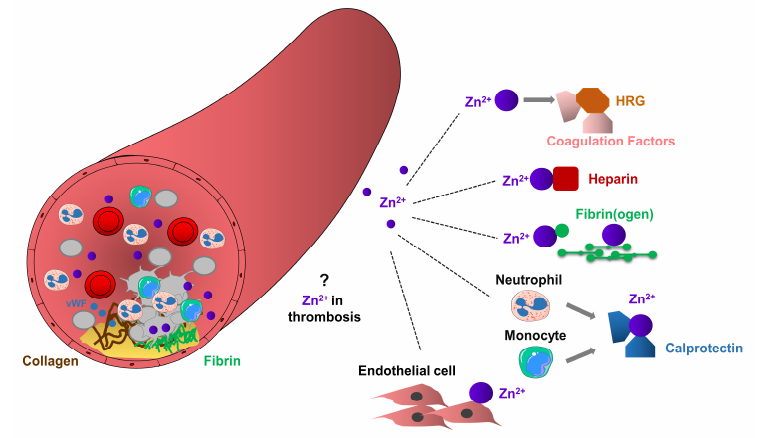
Figure 3. Potential role of Zn 2 + in arterial thrombosis. Arterial thrombosis occurs in atherosclerotic plaque rupture, as a result of clot formation, leading to platelet aggregation, thrombus formation and vessel occlusion. Platelets through glycoproteins, interact with collagen or von Willebrand Factor (vWF), change their shape and adhere to the site of injury. Adherent platelets become activated and release their granule content leading to the recruitment of additional circulating platelets. Extracellular Zn 2 + or Zn 2 + released from platelet granules may enhance thrombosis by mediating interactions between HRG and coagulation factors, Zn 2 + sequesters heparin, or interact with fibrinogen and fibrin, thereby enhancing fibrin deposition and stimulating recruitment of circulating platelets and subsequent thrombus growth. Calprotectin released from neutrophils and monocytes may interact with Zn 2 + and consequently enhance prothrombotic events. Procoagulant endothelial cells may provide favorable surface to the accumulation of Zn 2 + , thereby enhancing thrombosis.